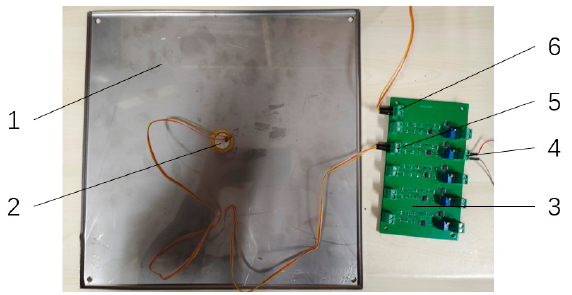
Figure 9. Structure of loss monitoring sensor: 1—Metal impact plate; 2—piezoelectric ceramics; 3—signal processing circuit PCB; 4—signal output terminal; 5—signal input terminal; 6—power